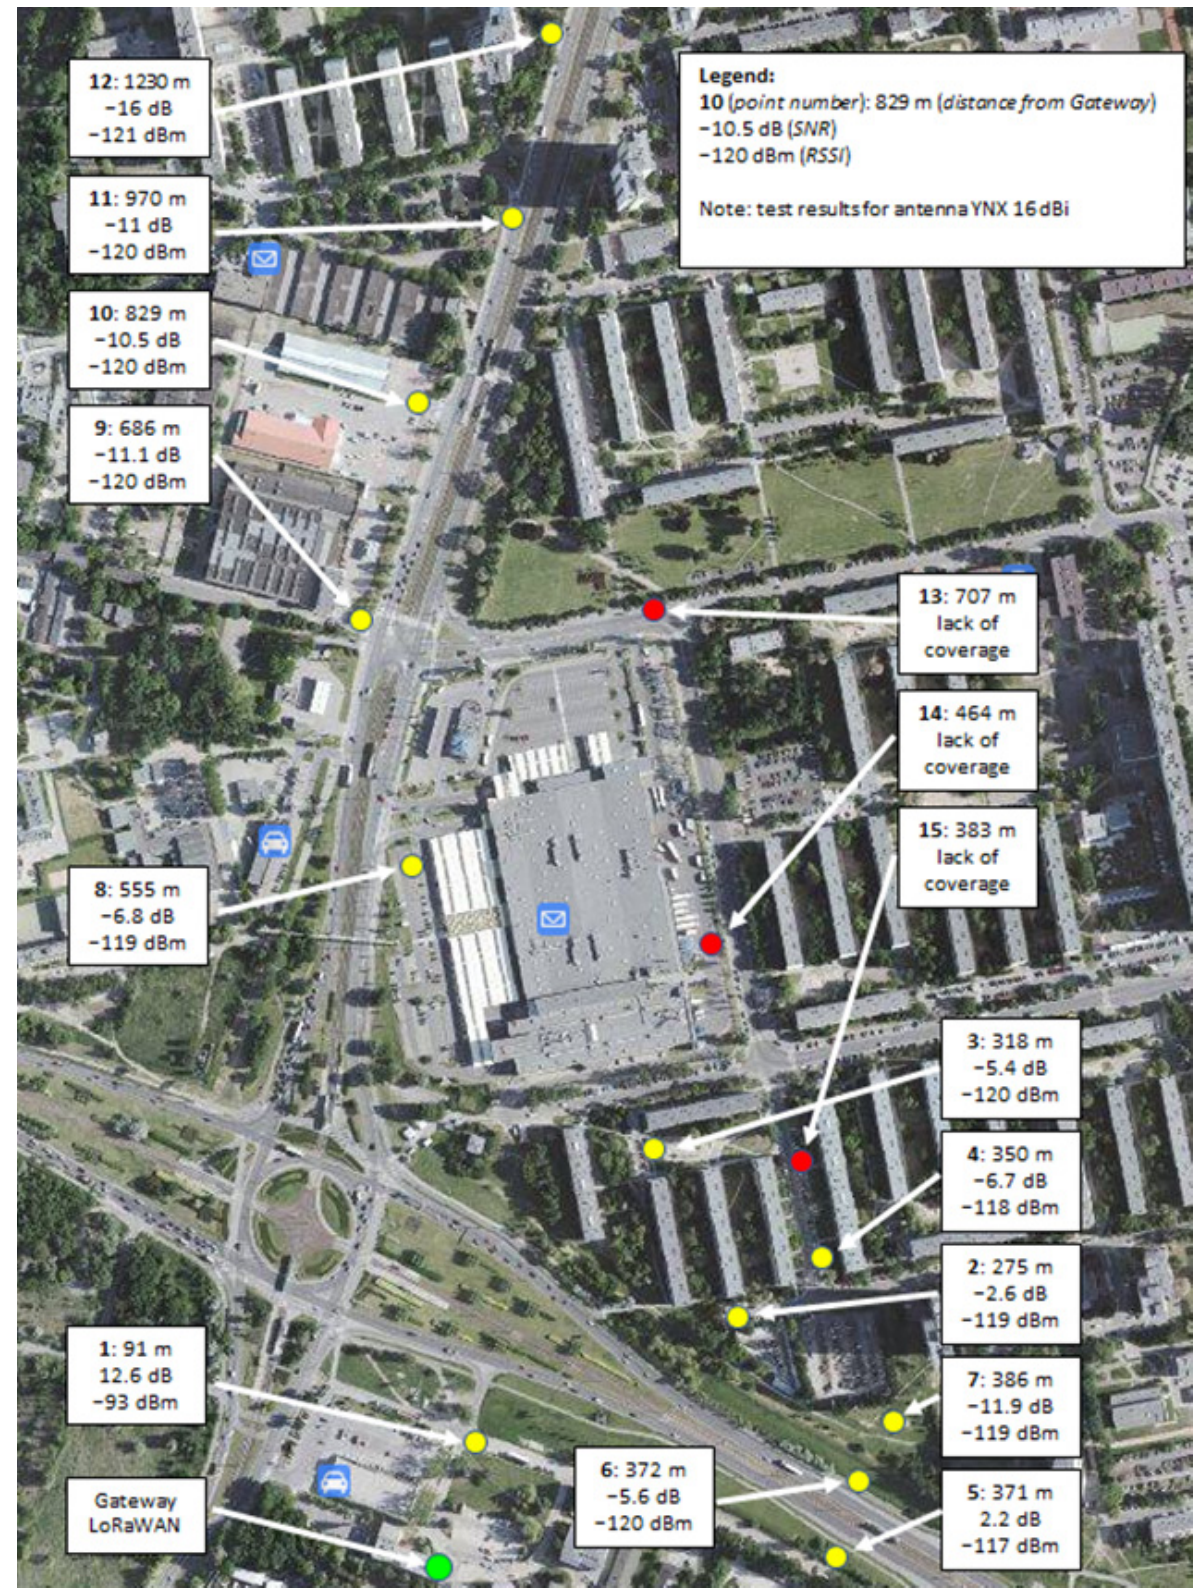
Figure 3. Map of the testing